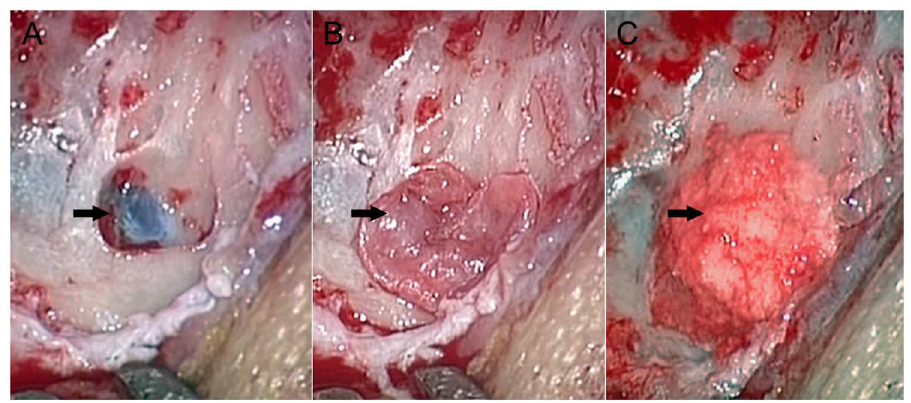
Fig 1. Intraoperative photographs of a patient (Patient 13) with complete resolution of PT following surgery. (A) The exposed dehiscence (arrowhead). (B) The dehiscence covered by the temporalis fascia (arrowhead). (C) The autologous bone powder overlays the temporalisfascia and are fixed using a medical